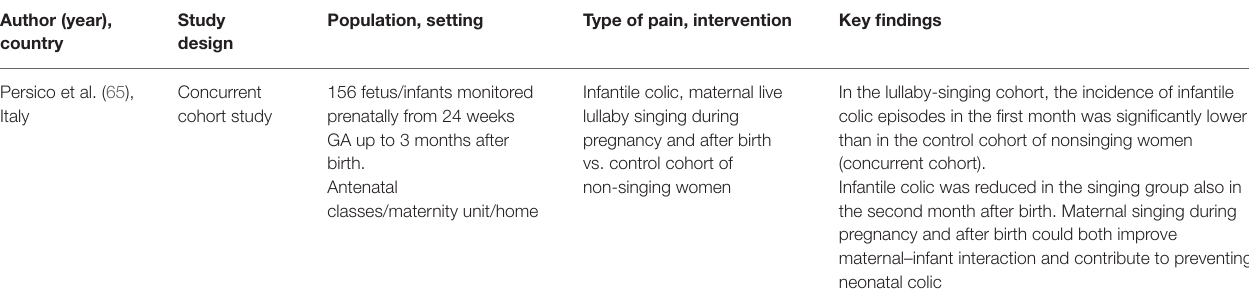
TABLE 6 | Evidence for parent-delivered interventions: live parental infant-directed singing. Author (year),